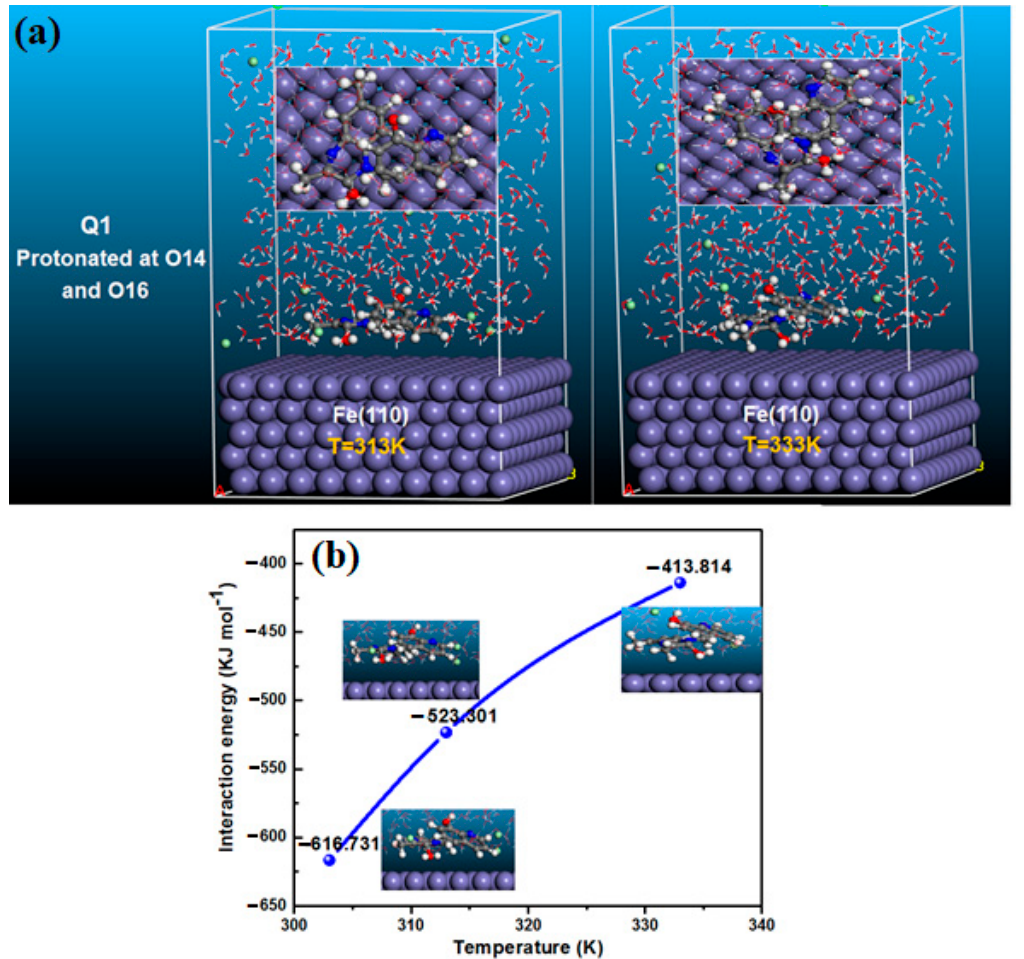
Figure 10. ( a ) Stable adsorption configurations of Q1 in its protonated forms and ( b ) dependence of interaction energy on the temperature for adsorbed Q1 molecule on Fe (110).